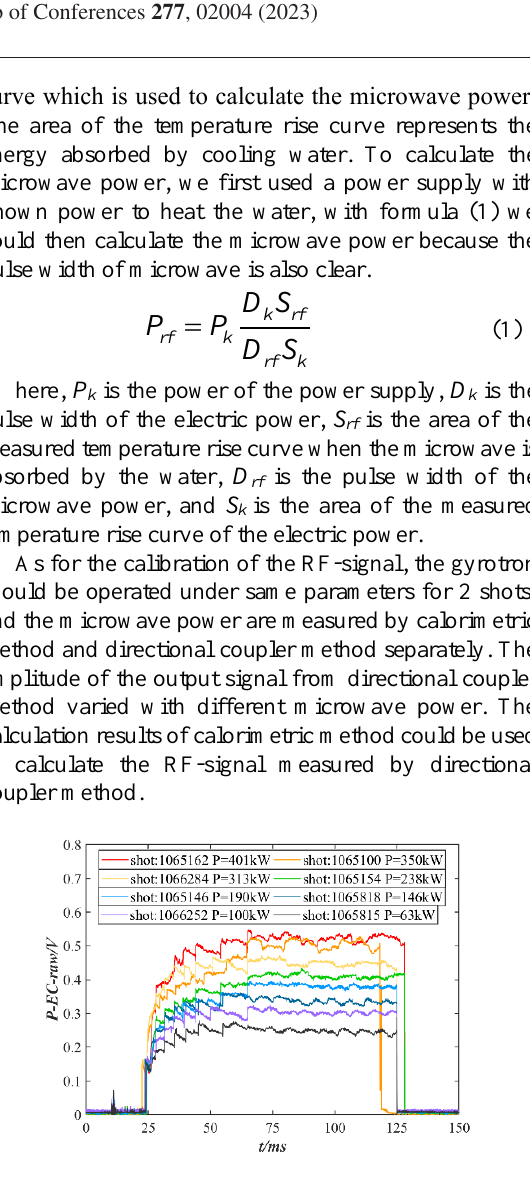
Fig. 6. Measured RF signal during gyrotron operation. Different shot has different power, therefore the RF signal has different value.